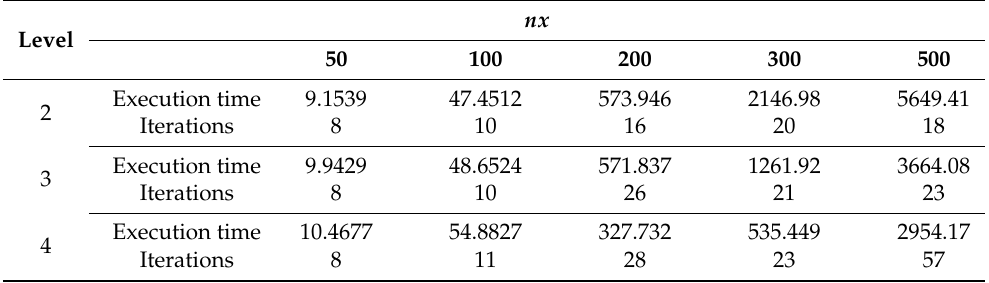
Table 4. Convergence behavior and performance of V cycle of AGAMG in combination with deflation technique and MGenFAspI with droptol = 0 and l fill = 1 for 3D Poisson model problem. Level